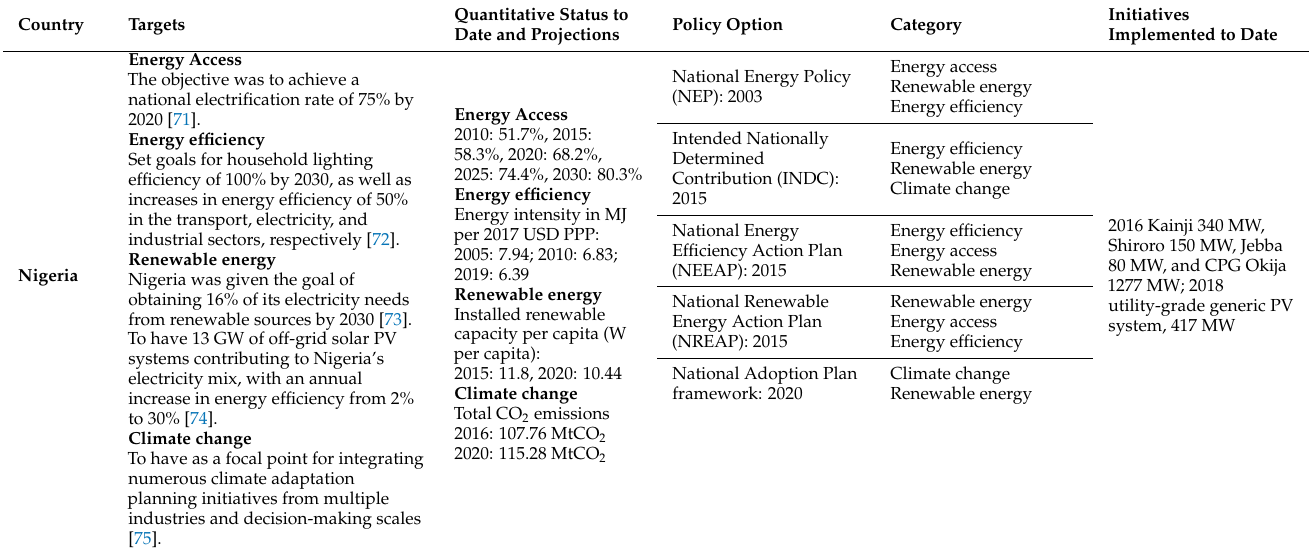
Table 12. Nigeria (data from